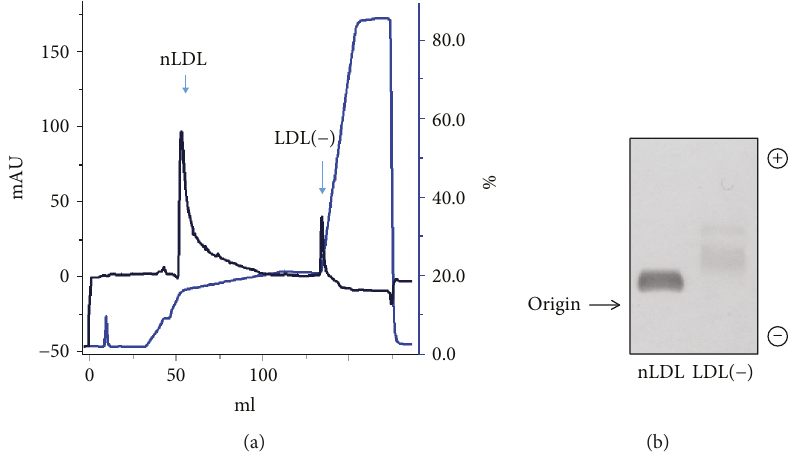
Figure 1: Characterization of LDL(-) in rabbit plasma. Rabbits were fed an atherogenic diet for 6 weeks, then LDL was isolated by ultracentrifugation and loaded onto a UnoQ6 column to separate native (n)LDL and electronegative LDL (LDL(-)). (a) Representative fast protein liquid chromatographic analysis showing the distribution of the nLDL and LDL(-). (b) Isolated nLDL and LDL(-) were analyzed by agarose gel